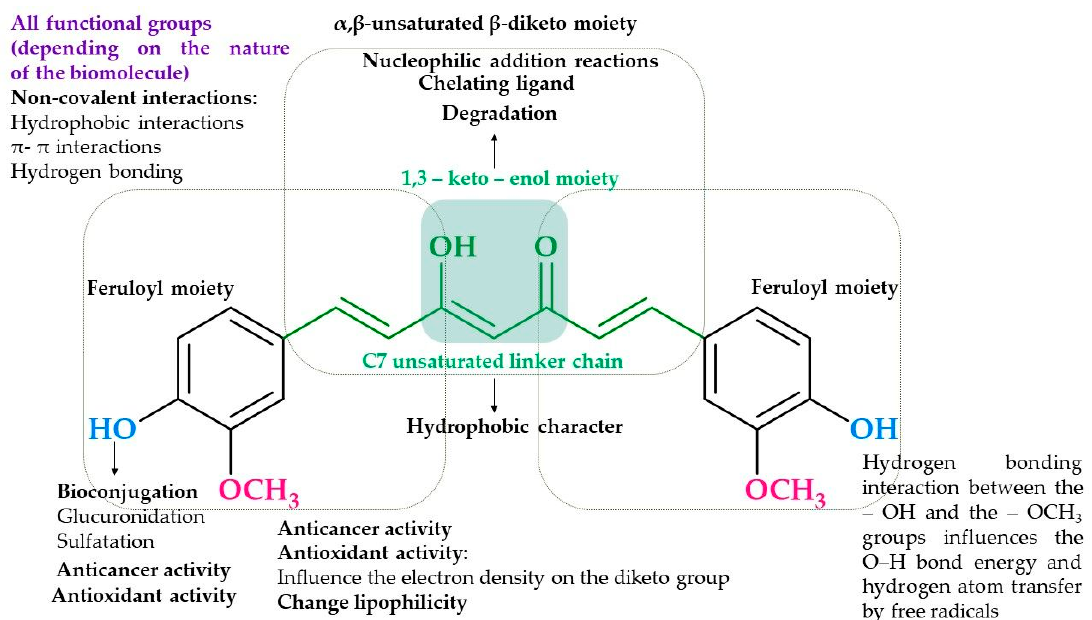
Figure 1. The curcumin functional groups of importance for biological activity. The figure was prepared following the references: [14,17].